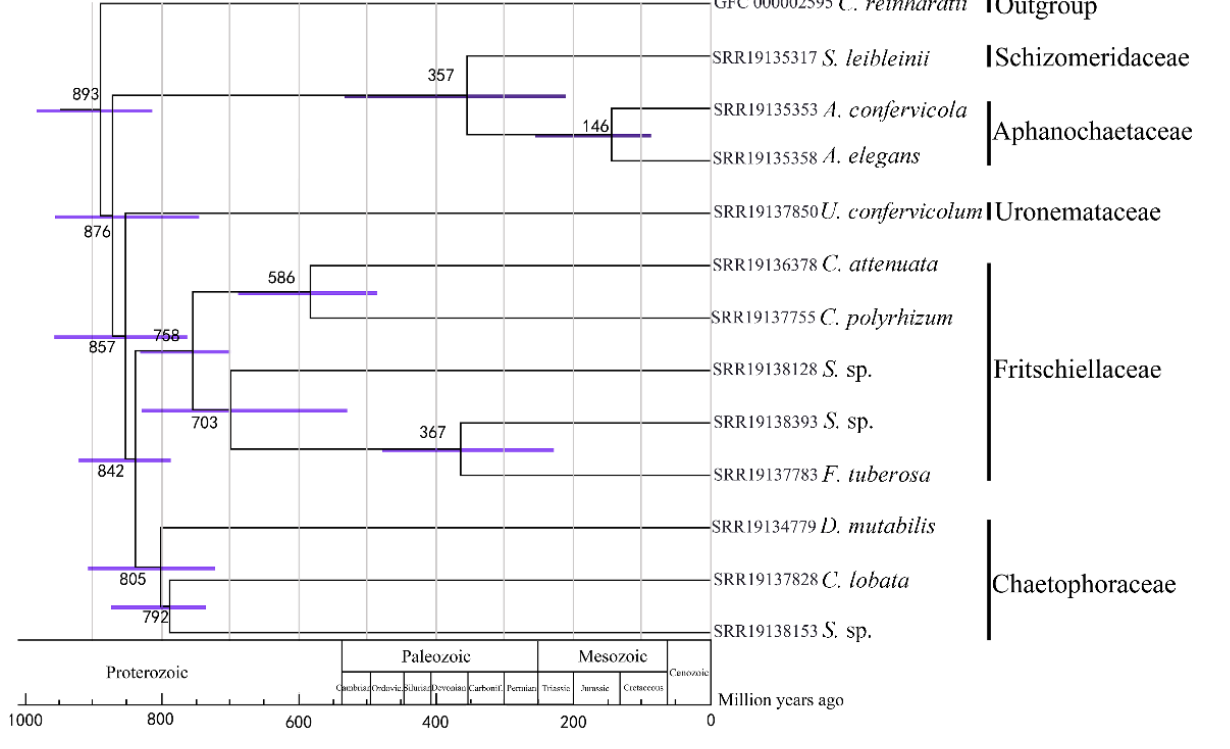
Figure 4. Divergence time estimated by fossil calibration. Node numbers represented estimated time (Mya). The purple bar represented range of 95% HPD.